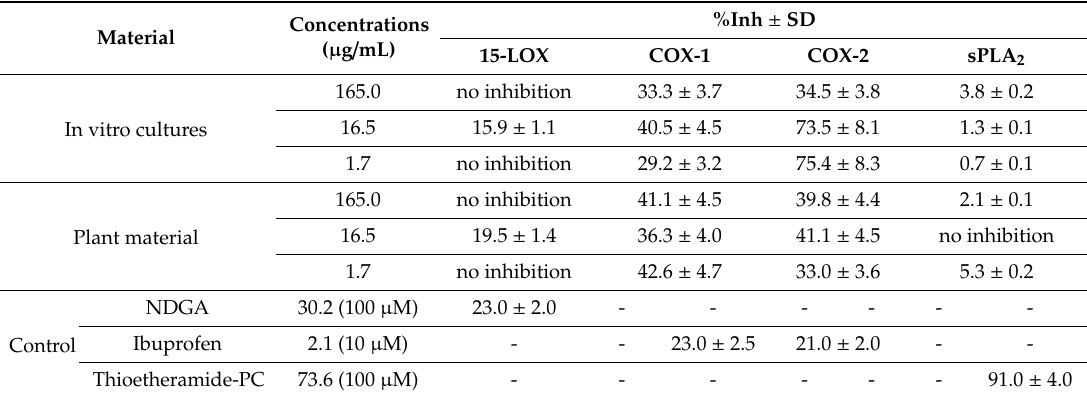
Table 5. In vitro inhibition activity (%Inh ± SD) of studied extracts from N. o ffi cinale microshoot cultures grown in RITA ® bioreactors over 10 days growth periods, and N. o ffi cinale herb extracts against 15-LOX, COX-1, COX-2 and sPLA 2